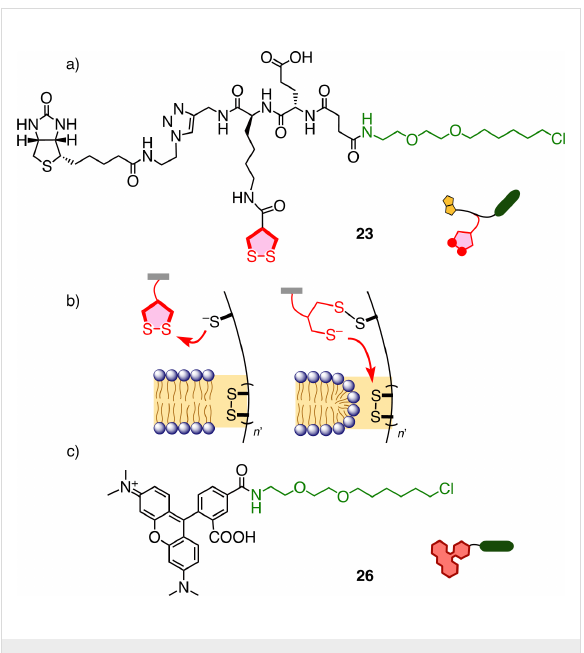
Figure 5: Structure of a) the trifunctional transporter 23 and c) the HaloTag reporter 26 . b) Schematic mechanism of the thiol-mediated uptake of COCs with dynamic covalent disulfide exchange with exofa- cial thiols (left), preceding walking along the disulfide tracks, and micellar pores